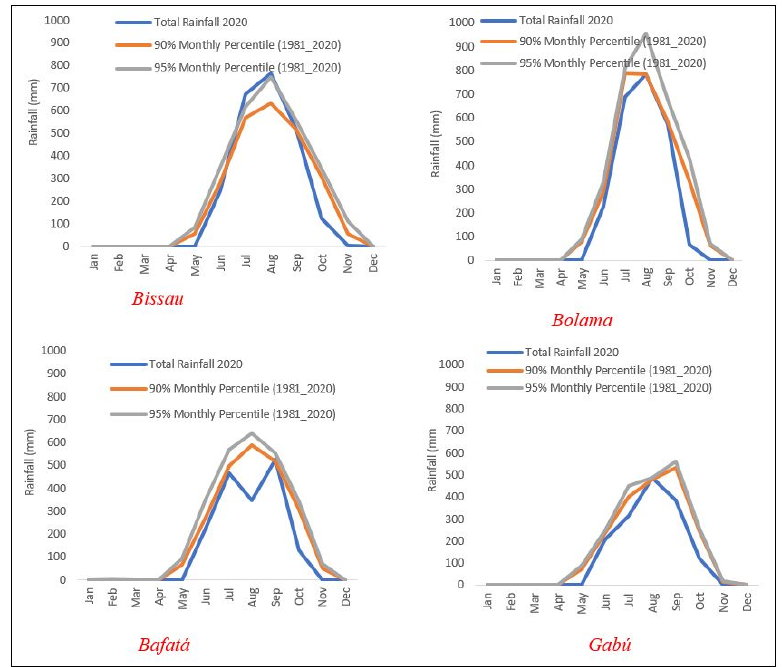
Figure 5. 2020 monthly precipitation and corresponding 90 and 95 percentiles of daily precipitation series over 1981–2020. Data source: National Institute of Meteorology of Guinea ‐ Bissau.